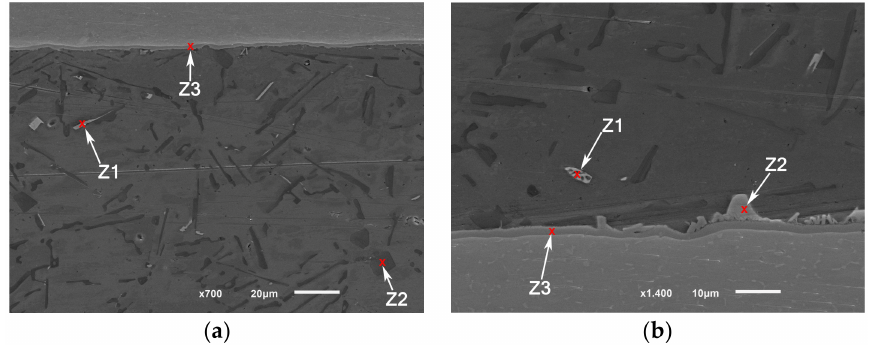
Figure 24. SEM images (SEI) of a 13/585 brazed joint: ( a ) The active parent part interface with the filler; ( b ) The passive part interface. EDS analyses results are shown in Table